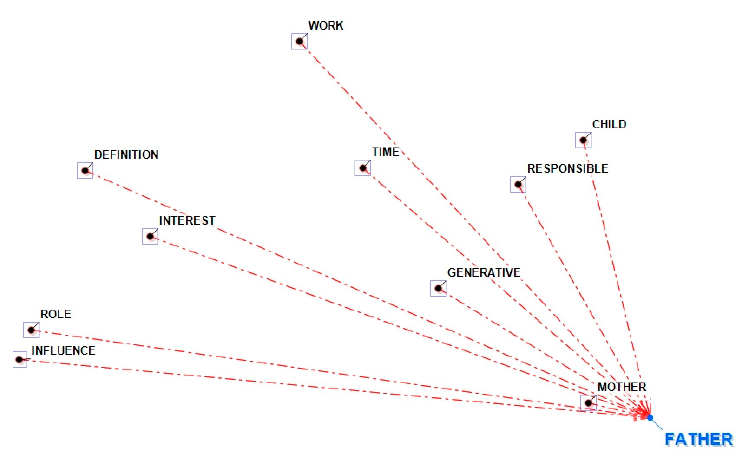
Figure 6. Predecessors of “father”.